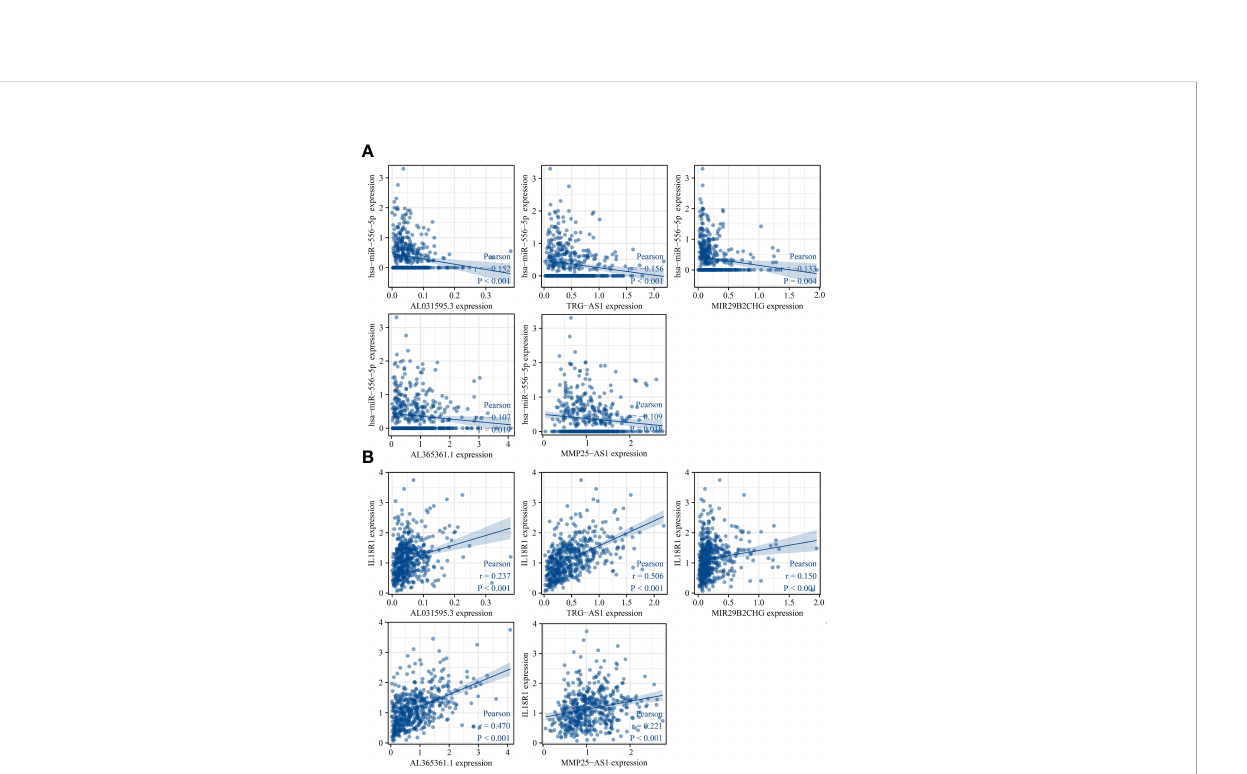
FIGURE 12 miR-556-5p and IL18R1 expression levels were associated with the AL031595.3, MIR29B2CH, AL365361.1, MMP25-AS1, and TRG-AS1 expression levels in LUSC. (A) miR-556-5p; (B) IL18R1. LUSC, lung squamous cell